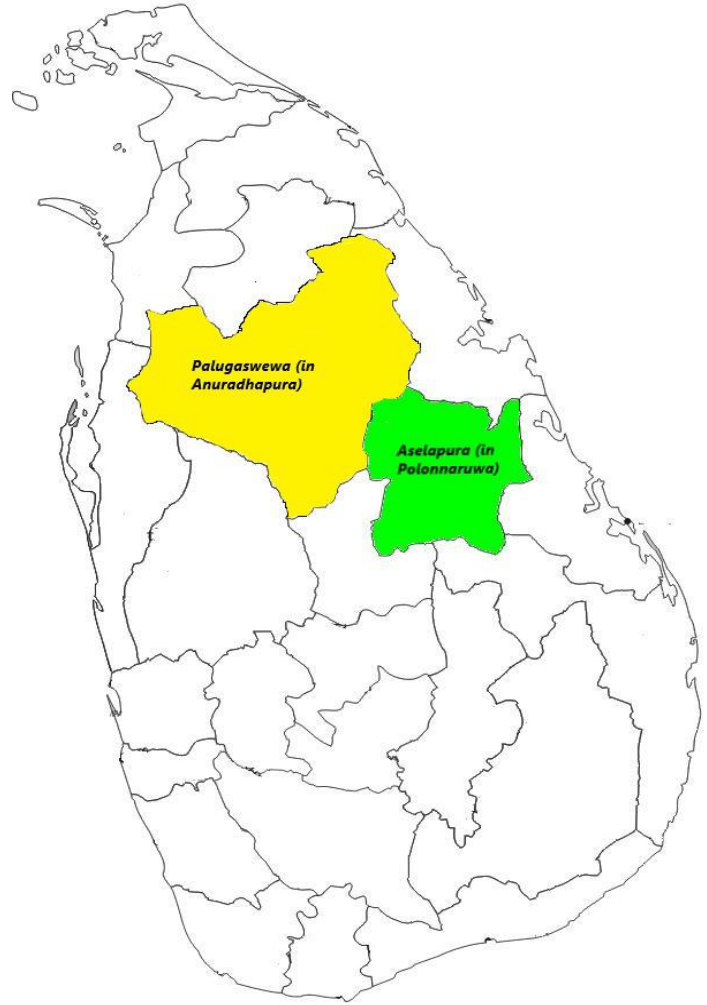
Figure 3. A 1:2,000,000 scale map of Sri Lanka. The Palugaswewa tank cascade system exists in the Anuradhapura District of Sri Lanka (the area highlighted in yellow), while the Aselapura surface irrigation system exists in the Polonnaruwa District of Sri Lanka (the area highlighted in green).